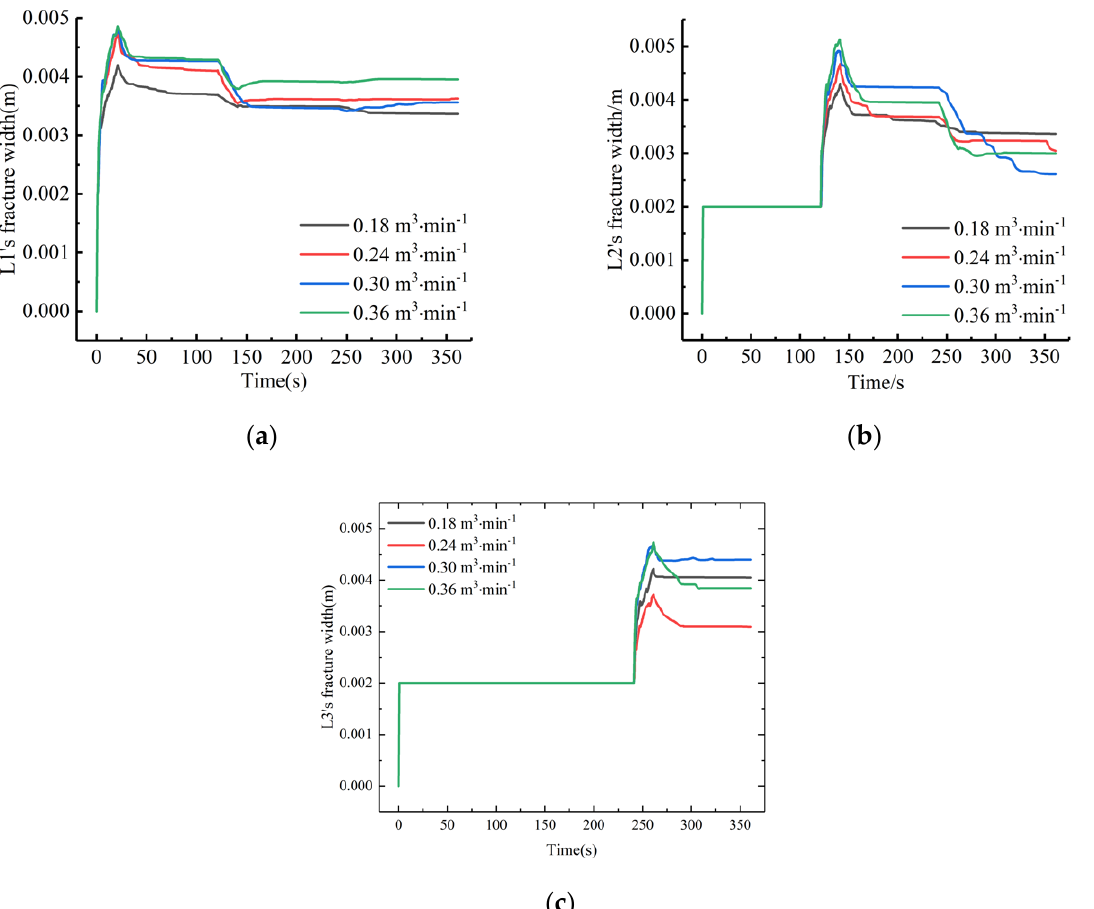
Figure 15. Variation curves of the fracture width of CBM reservoirs under various fracturing fluid pumping rates. ( a ) L1, ( b ) L2, ( c ) L3.